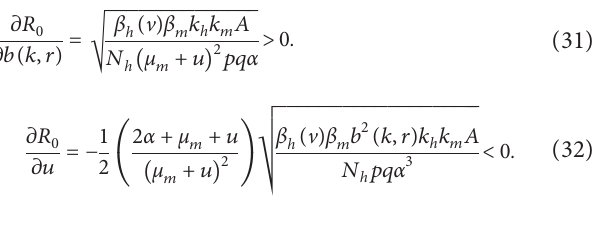
� 1. The red colored region defines endemic 0